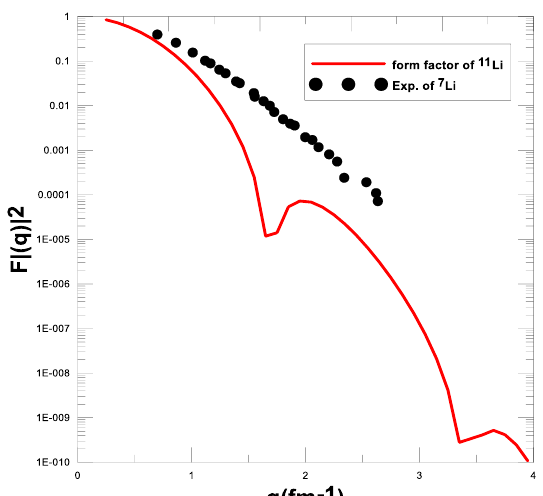
Figure 4: Comparison between the calculated elastic form factors of 11 Li and the experimental data of stable 7 Li